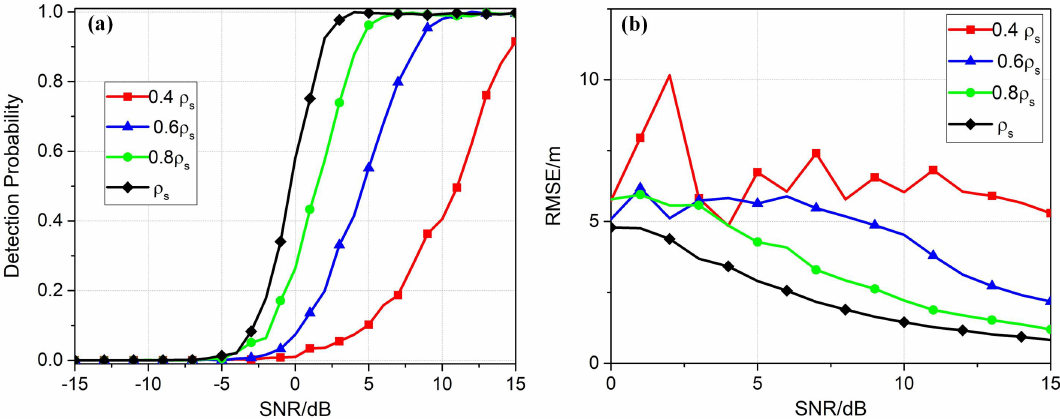
Figure 8. Super-resolution performance of the proposed CS-GLRT for the separation of 0.4 ρ s (red, square), 0.6 ρ s (blue triangle), 0.8 ρ s (green circle), and ρ s (black, diamond), respectively: ( a ) detection probability; and ( b ) RMSE of the elevations.